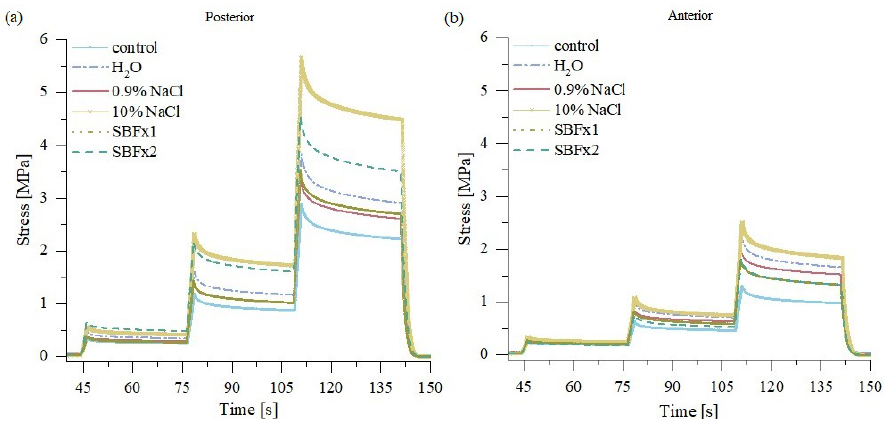
Figure 11. Mean stress relaxation curves for samples from the ( a ) posterior side and ( b ) anterior side of the tendon; for control samples and samples rehydrated in different solutions; n = 10.